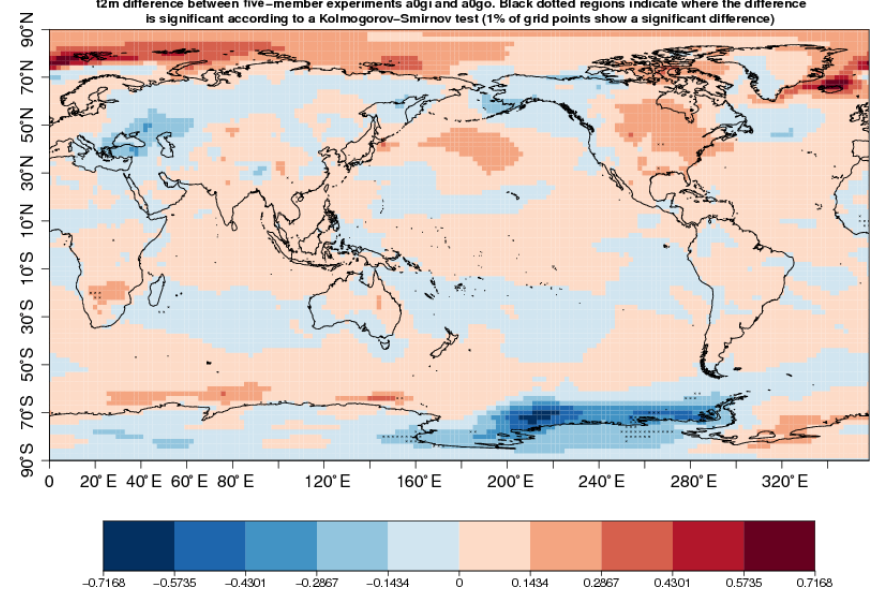
Figure 8. Same as Fig. 5 but for the pair of experiments carried out with EC-Earth 3.2, namely a0gi and